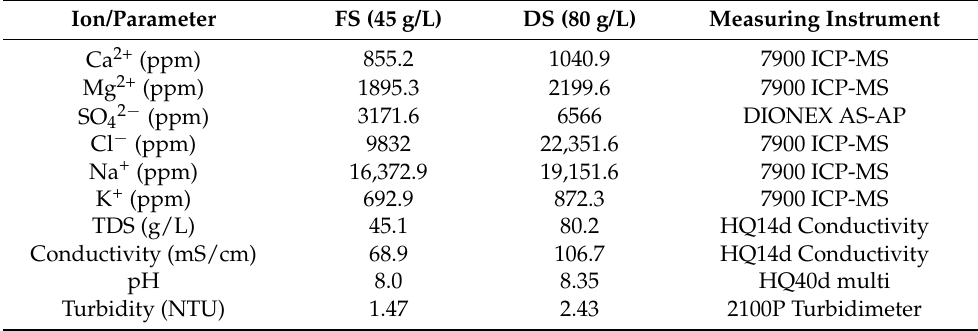
Table 2. Characteristics of FS and DS used in the FO process.